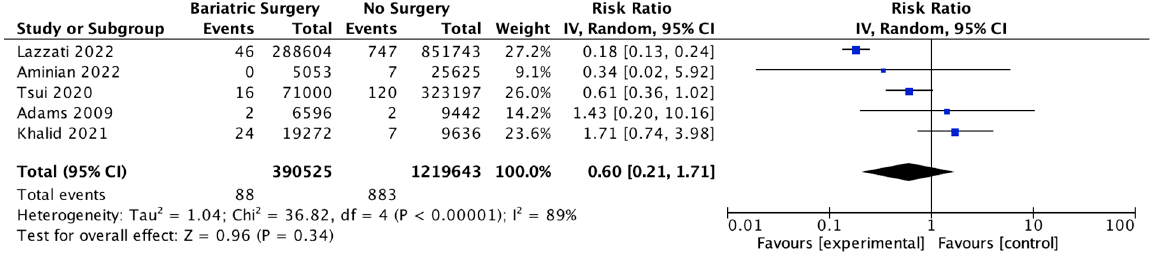
Figure 17. Gastric cancer incidence [38–40,42,49].